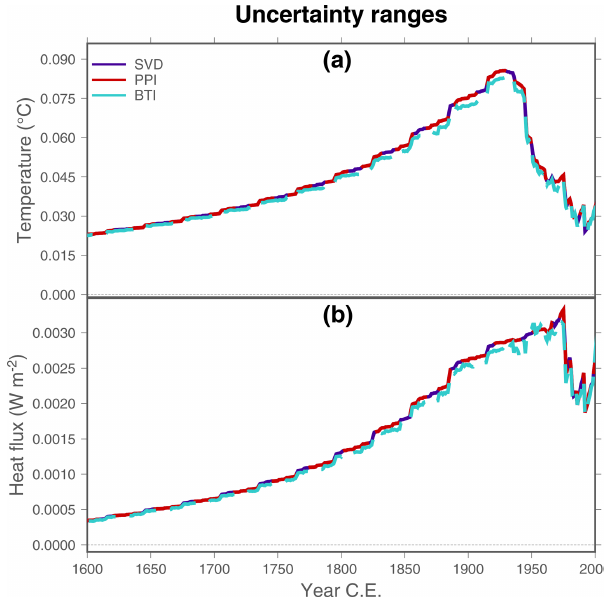
Figure 8. Uncertainty ranges for the three techniques analyzed here, using error propagation to estimate the uncertainties in the SVD and PPI global averages. (a) Uncertainty ranges of the global av- eraged temperature histories from Xibalbá subsurface temperature profiles using error propagation of SVD and PPI inversions (pur- ple and red lines) and standard BTI inversions (light blue lines). (b) Uncertainty range of the global averaged heat flux histories from Xibalbá subsurface temperature profiles using error propagation of SVD and PPI inversions (purple and red lines) and standard BTI inversions (light blue lines). All results were obtained considering constant thermal diffusivity and conductivity; thus, differences are caused only due to the different aggregation